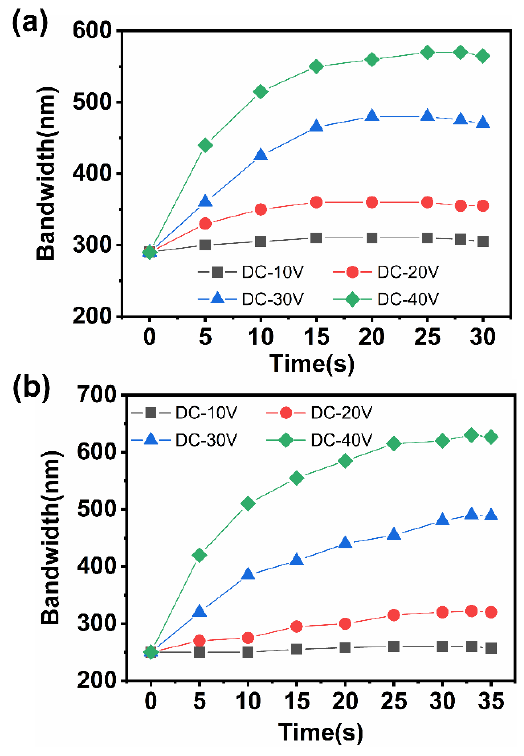
Figure 7. Reflection bandwidth on voltage holding time: ( a ) sample 1 and ( b ) sample 5.